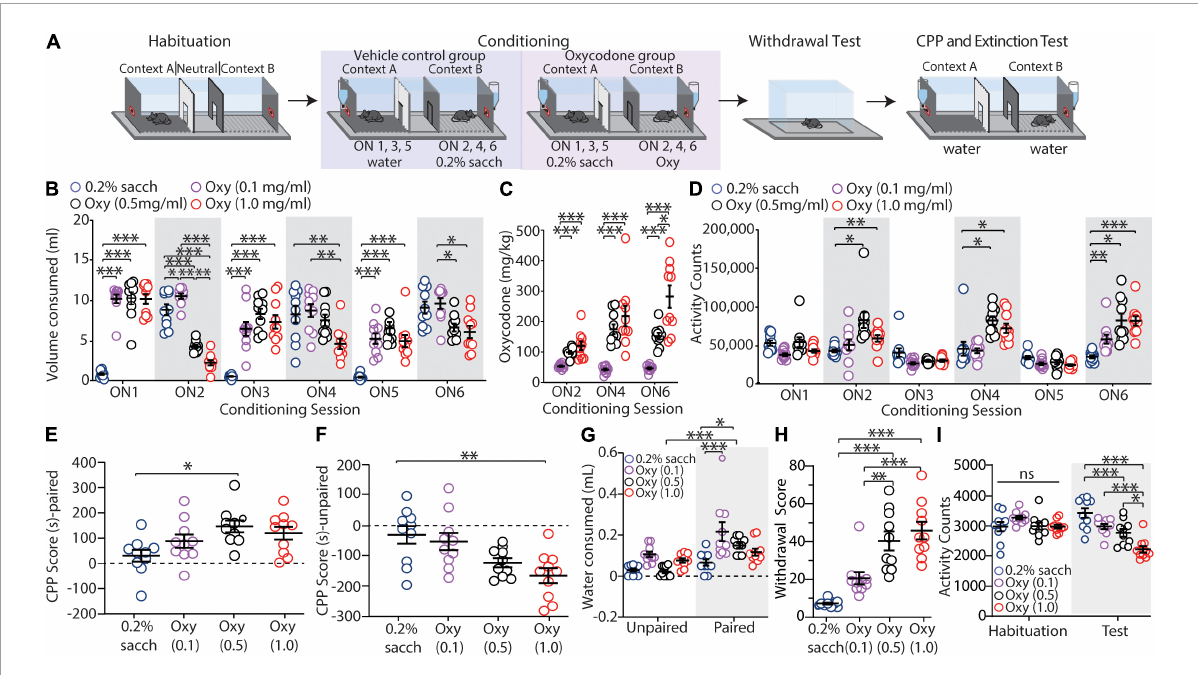
FIGURE1 Oxycodone oral self-administration evokes conditioned place preference, context-induced drug-seeking, and withdrawal. (A) Timeline of the behavioral procedure of saccharin control or oxycodone oral-SA-CPP. Mice underwent habituation sessions followed by 6 overnight conditioning sessions where they were given access to water (control) or saccharin (experimental) in the unpaired chambers and saccharin (control) or oxycodone diluted in saccharin solution (experimental) in the paired chambers. 1-2 days later, mice were given withdrawal testing followed by a 2 h extinction test. (B) Summary graph showing the volume of solution consumed between groups during overnight (ON) conditioning sessions 1-6 (ON 1-6) [ F ( 15 , 180 ) = 29.84, p < 0.0001, two-way repeated-measures ANOVA, Bonferroni post hoc test]. (C) Summary graph showing the mg/kg of oxycodone consumed during ON 2, 4, and 6 [ F ( 4 , 54 ) = 13.49, p < 0.001, two-way repeated-measures ANOVA, Bonferroni post hoc test]. (D ) Summary graph showing the locomotor activity counts across conditioning sessions [ F ( 15 , 180 ) = 7.605, p < 0.0001, two-way repeated-measures ANOVA, Bonferroni post hoc test]. (E) Summary graph showing the CPP score for all groups in the paired chamber [ F ( 3 , 36 ) = 4.215, p = 0.0118, one-way ANOVA with Bonferroni post hoc test]. (F) Summary graph showing the CPP score for all groups in the unpaired chamber [ F ( 3 , 36 ) = 6.428, p = 0.0016, one-way ANOVA with Bonferroni post hoc test]. (G) Summary graph showing mLs of water consumed during the 2 h extinction test [ F ( 3 , 72 ) = 2.743, p = 0.0493, two-way ANOVA with Bonferroni post hoc test]. (H) Summary graph showing the withdrawal scores for all groups [ F ( 3 , 36 ) = 21.88, p < 0.0001, one-way ANOVA with Bonferroni post hoc test]. (I) Summary graph showing total activity counts during habituation and 24 h following the last conditioning session [ F ( 3 , 36 ) = 24.29, p < 0.0001, two-way repeated-measures ANOVA with Bonferroni post hoc test] (n = 10 for each group). ∗ p < 0.05, ∗∗ p < 0.001, ∗∗∗ p <